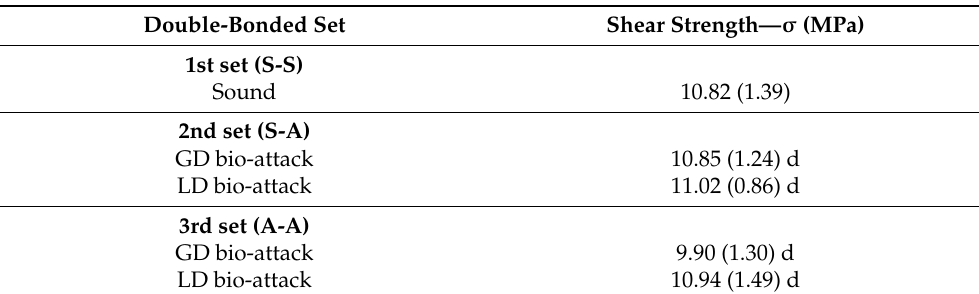
Table 2. The shear strengths ( σ ) of glued joints in the double-bonded sets consisting of Norway spruce lamellas of type II and PUR glue.